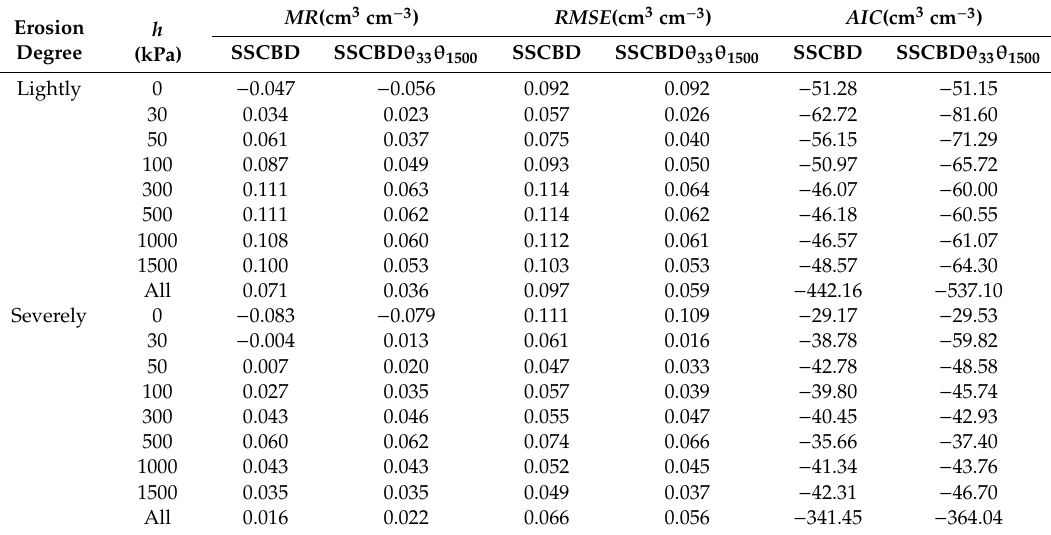
Figure 5. Comparison of the measured and simulated soil water contents before correction, using the input of SSCBD and SSCBD θ 33 θ 1500 , respectively, for the lightly and severely eroded soils. Table 6. MR , RMSE and AIC between simulated and measured soil water contents for the lightly and the severely eroded